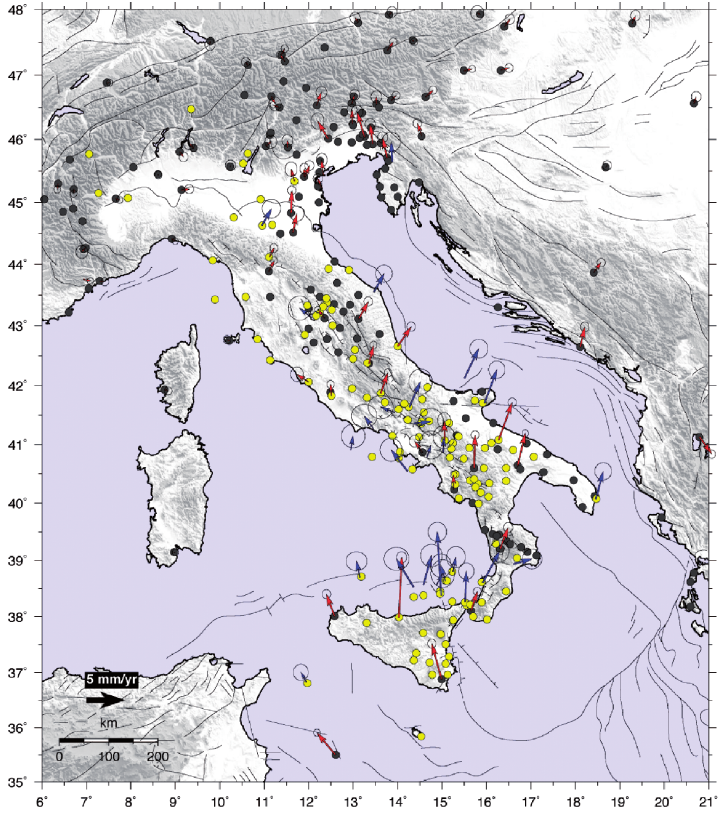
Fig. 6. Velocity field in Italy and surrounding regions from GPS (blue) and CGPS (red)